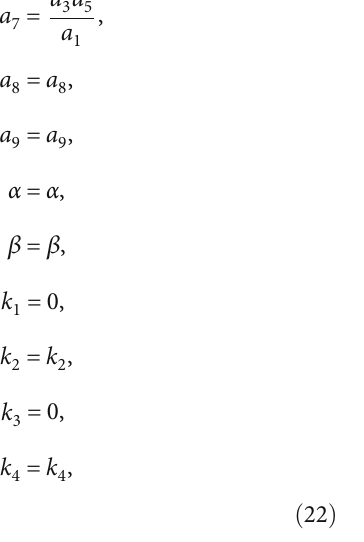
= 1 , a = 1 : 5 , a = 0 , a = 2 , a = 4 , a = 0 , a = 1 , α = 1 , β = 1 , k 1 3 4 5 6 8 9